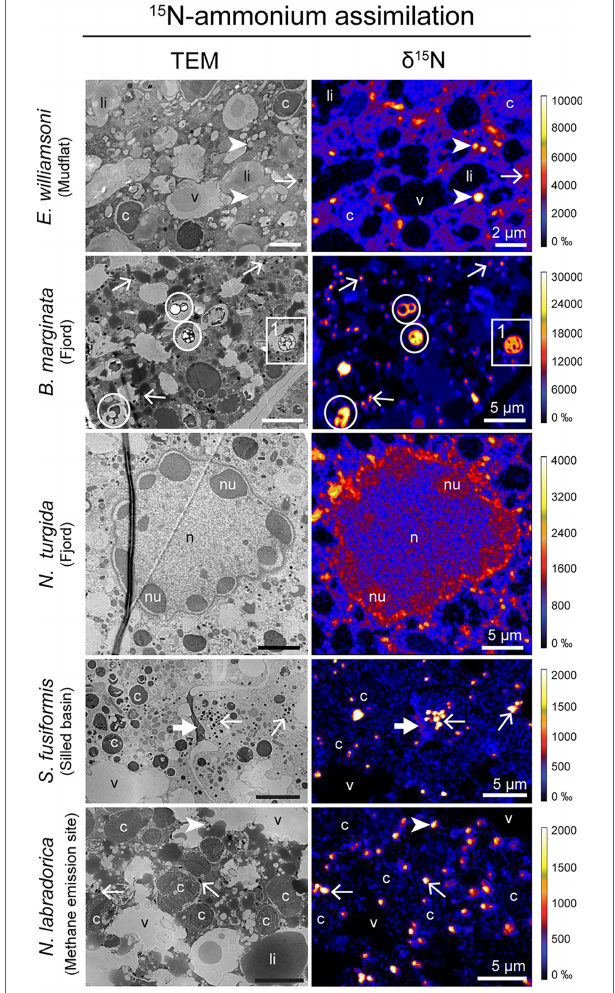
FIGURE 1 | TEM micrographs of different benthic foraminiferal species’ cytoplasm and corresponding NanoSIMS images of 15 N-ammonium assimilation (expressed as δ 15 N in ‰). Arrows: electron-opaque bodies, arrowheads: fibrillar vesicles, thick arrow: apertural collars, circles: prokaryote-like vesicles, c, kleptoplasts; li, lipid droplets; n, nucleus; nu, nucleoli; v, vacuoles. Inset 1 is presented in Figure 2A